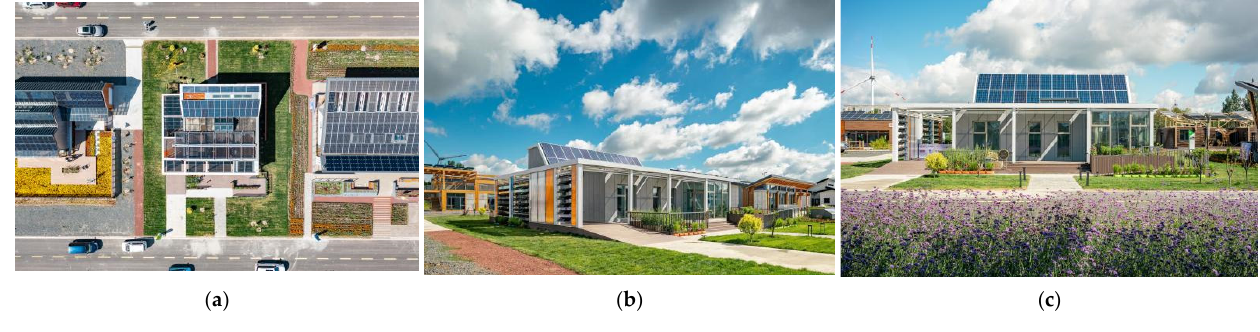
Figure 24. Photos of T&A House. ( a ) Project construction base; ( b ) southwest view of T&A House; ( c ) horizontal view of T&A